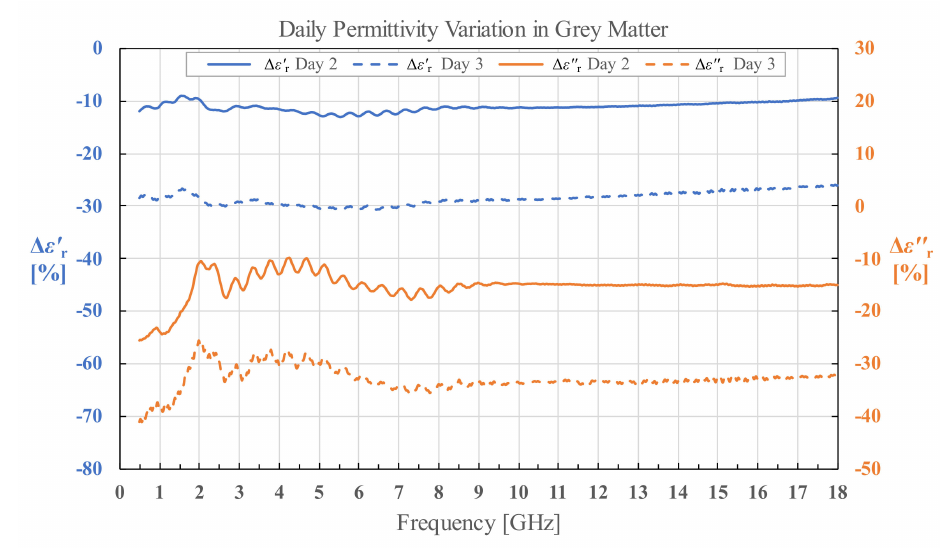
Figure 22. Permittivity change in human grey matter for brain H1 on day 2 and day 3. Table 2. Average percent change in ε (cid:48) r and ε (cid:48)(cid:48) r on day 2 and day 3 compared to day 1 for grey and white matter.